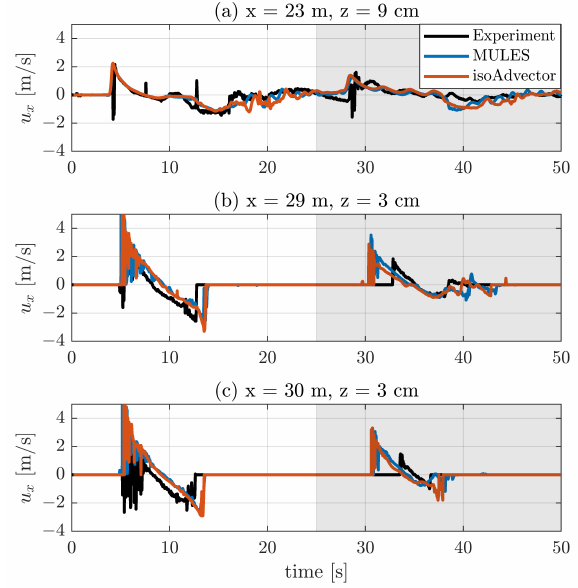
Figure 7. Comparison of cross-shore water velocity u x between the experiments and two models, using MULES and isoAdvector respectively, at three different cross-locations. Both models use the Engelund and Fredsoe [37] reference concentration model. The last 25 s are shown with a grey